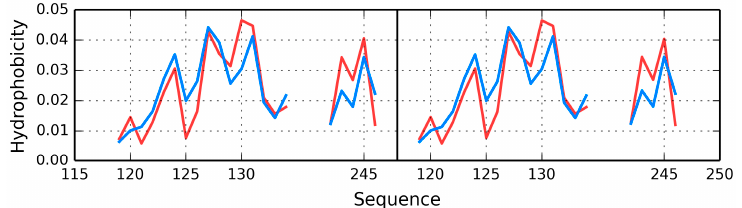
Figure 9. Hydrophobicity profile for the interface-domain in dystrophin comprising fragments of the A chain ( left ) (119–134 and 242–246) and analogous fragments of the B chain ( right ). Blue line: expected distribution; red line: observed distribution. The chart reveals good accordance between both profiles. Residues 119–134 form helixes, while residues 242–246 form β -folds.